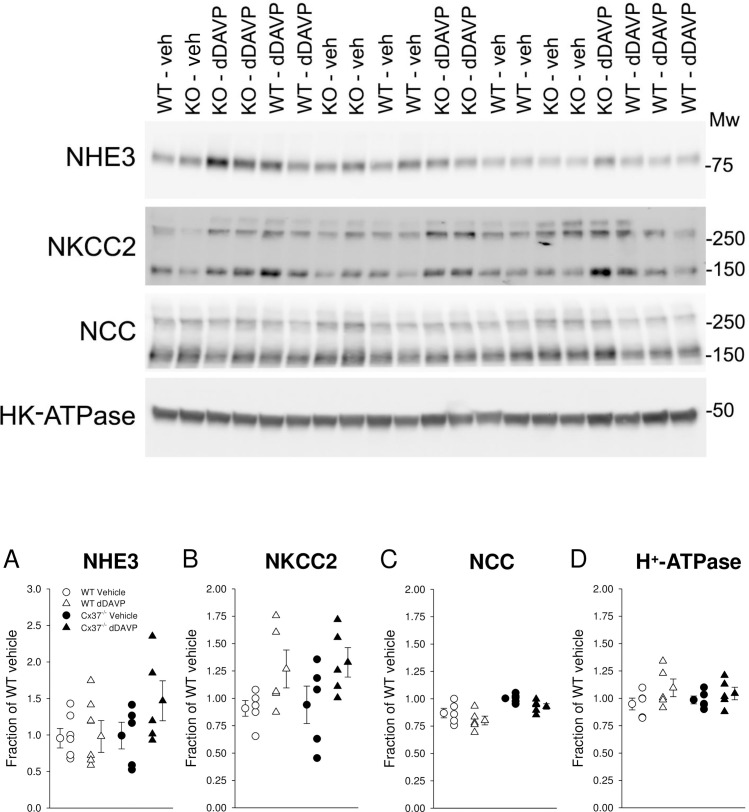
Renal abundance of major salt and proton transporting proteins.Sixty minutes after vehicle application no differences were observed in (A) NHE3, (B) NKCC2, (C) NCC or (D) H+-ATPase abundance. Systemic administration of dDAVP following suppression of endogenous vasopressin overnight (see Materials and methods for details) did not affect abundances of these proteins. Data are expressed as mean ± SEM and analyzed by paired and unpaired Student’s t-test, n = 5 each genotype and condition.